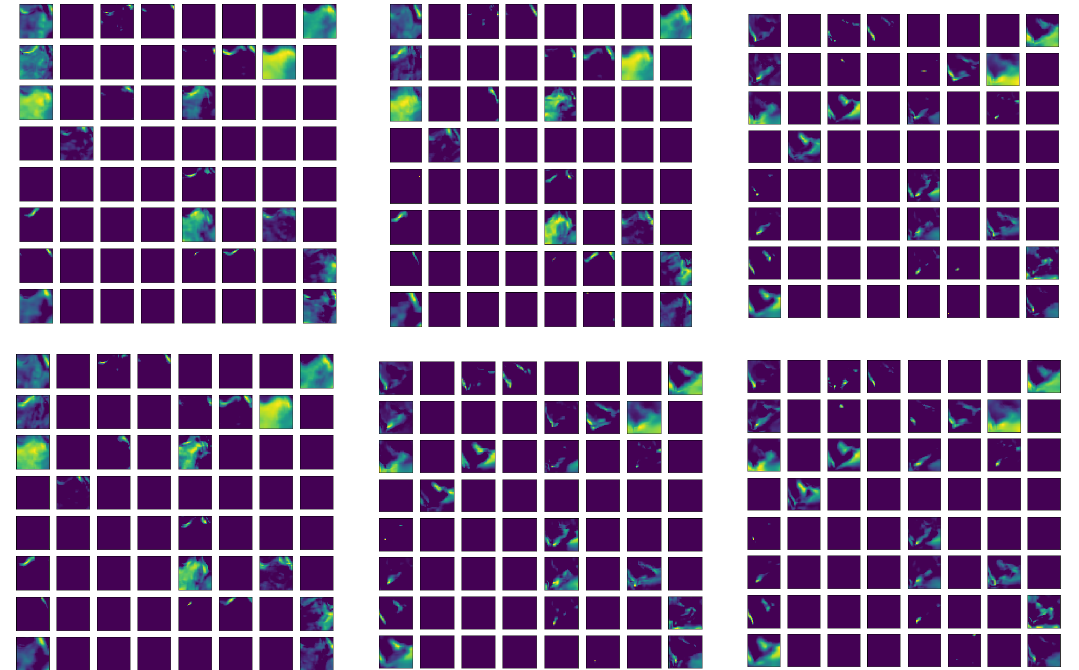
Figure 6. Feature map arrays for the first convolution layer (the layer after the input in the auto- encoder network of Figure 5a). Each map is of 30 × 30 dimensions covering the whole physical domain (approximately 1300 km × 1300 km). There are 64 such maps corresponding to the 64 convolution filters. The three channels are represented by the three parallel map arrays, and their order does not matter by the network design. The maps are coresponding to the specific humidity (variable q). The maps in the top row are for a randomly selected non-RI case, and the bottom row is for a RI case. Deep blue implies the value in a pixel is 0, and the brighter the color is, the higher the value in a particular pixel.